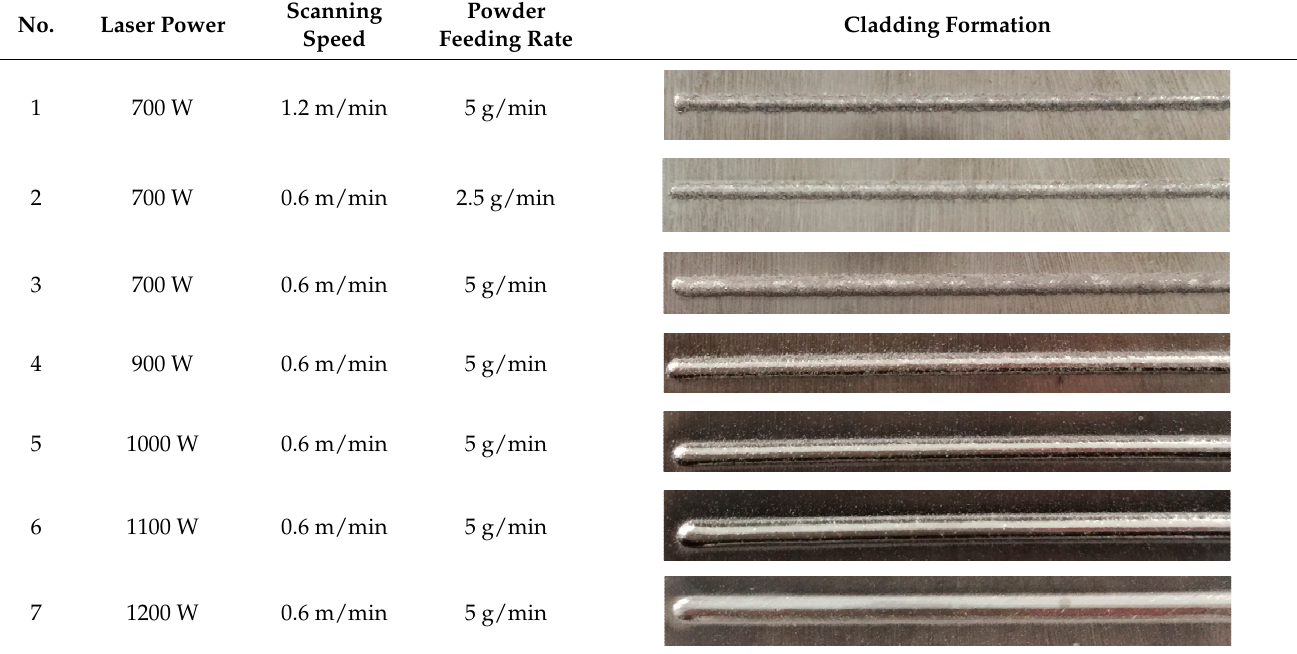
Table 5. Repairing formation in single pass under laser spot diameter of 2.5 mm.